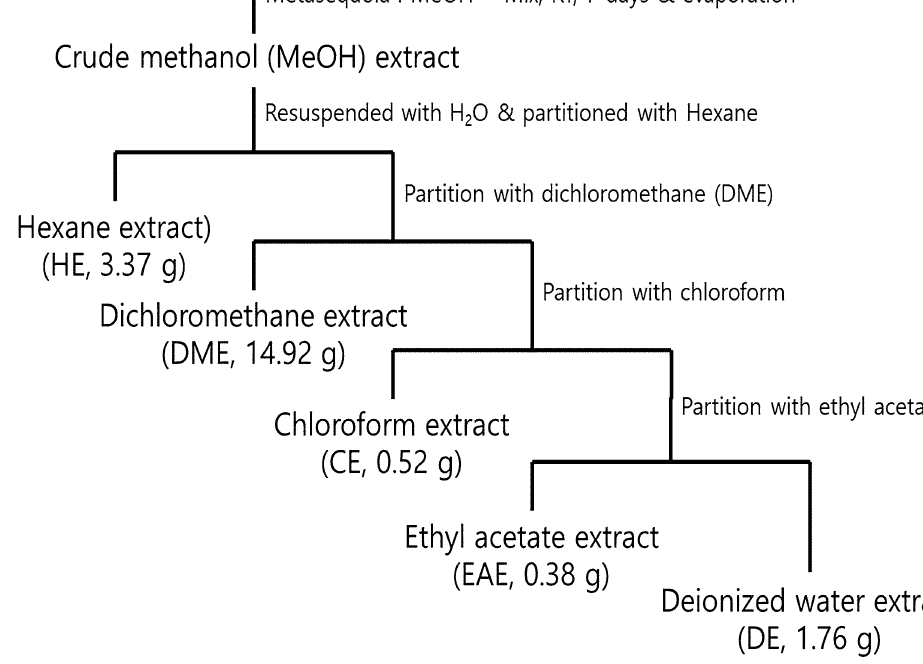
Figure 1. Partition of different solvent extracts through liquid–liquid